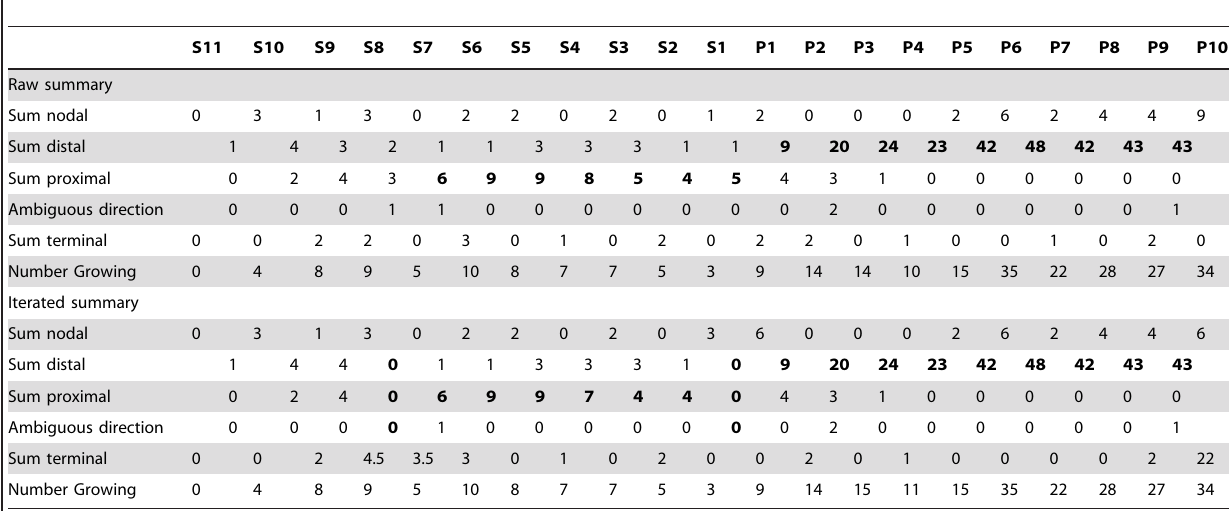
Table 2. Molt summary for primaries and secondaries in adult Hemiprocne mystacea